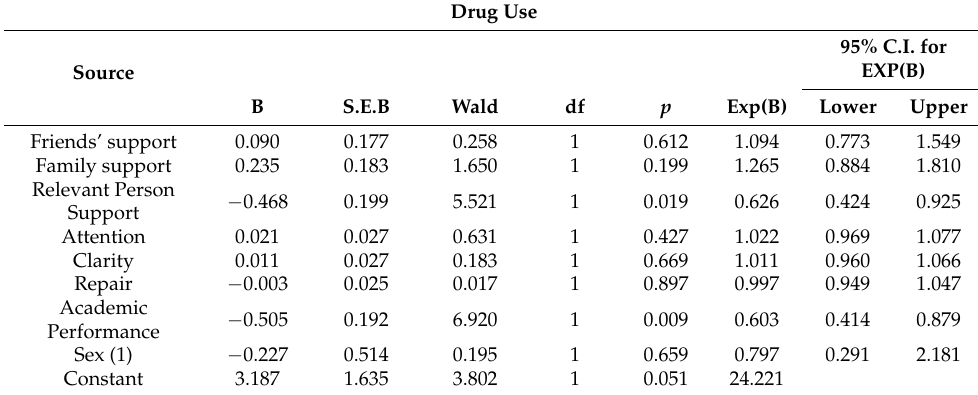
Table 3. Binary logistic regression model of substance consumption.